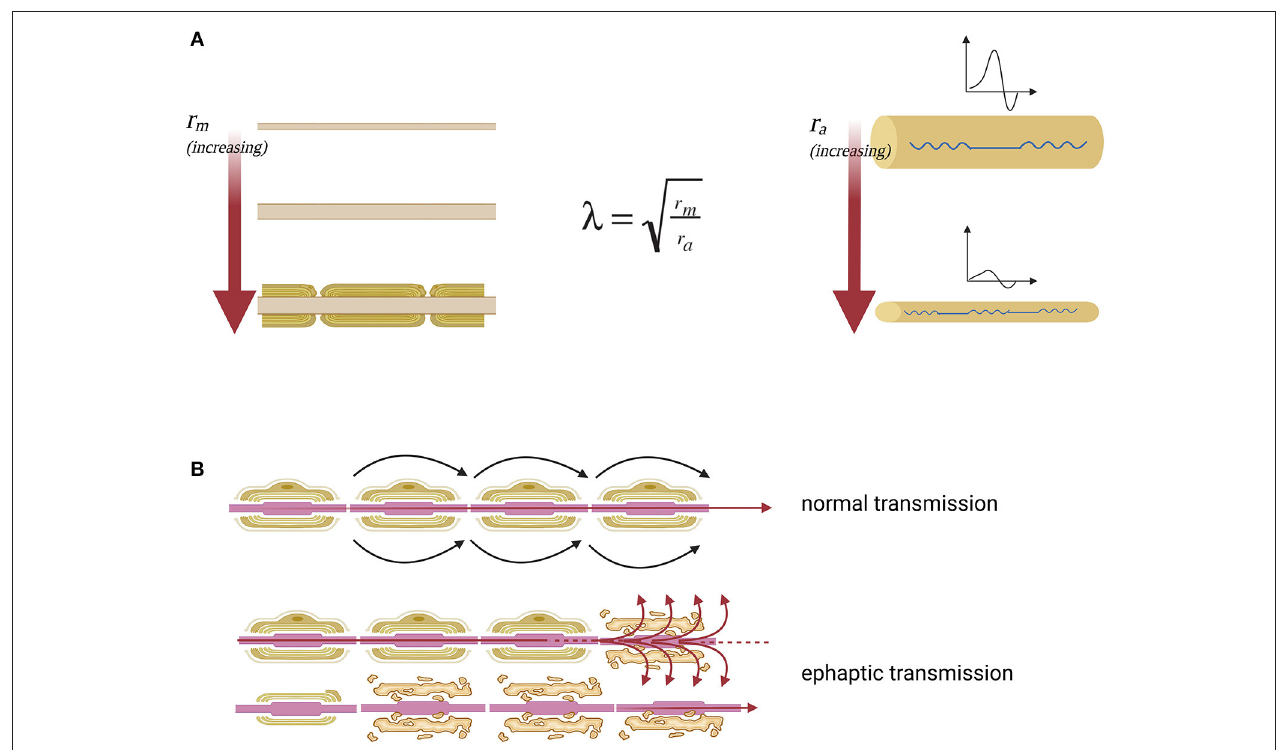
FIGURE 3 | Nerve impulse propagation in axons with normal and reduced diameter. (A) Lambda space constant ( λ ) is an index of how the difference in membrane potential propagates along with the fiber at distance. Moreover, space constant is directly proportional to the membrane resistance ( r m ), which opposes the escape of ions that must proceed along the axon to transmit the signal and inversely proportional to axial resistance ( r a ), which opposes the propagation of the action potential along the axon. The membrane resistance increases enormously with the myelination of the fiber, which isolates the axon from current leakage. The axial resistance instead is a direct measure of axonal diameter, so the greater the diameter of the axon, the easier it will be the propagation of excitation at a distance, the smaller the diameter of the axon, the greater the probability that the fiber will suffer a conduction block. From this model, it is clear that the fibers of small diameter are more sensitive to the effects of demyelination because they have high axial resistance. (B) The nerve fiber function deficit in the case of SPS can be explained as an effect of ephaptic transmission. In this way when an action potential arises, perturbing the extracellular medium, the excitation is transferred to neighboring axons. Specifically, there is a transverse propagation of excitation from one axon to another, independently of the synaptic